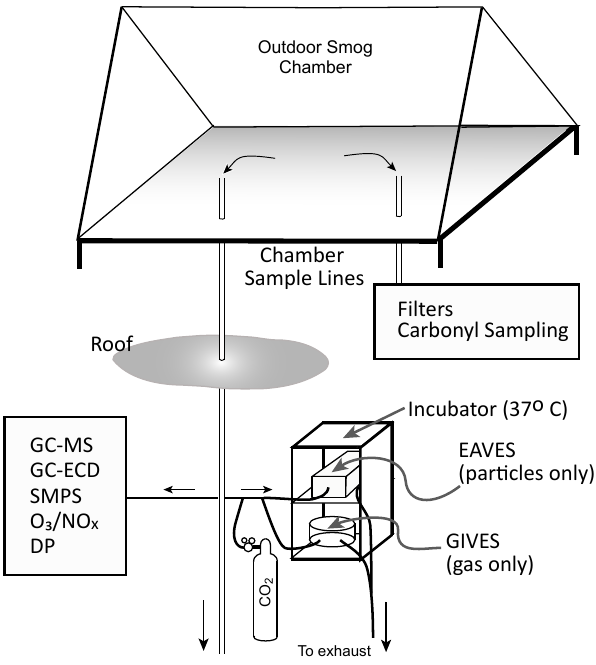
Fig. 1. Schematic of The Gillings Innovation Laboratory 120 m 3 Outdoor Chamber located on the roof of the four-story Gillings School of Global Public Health, UNC-CH. Sample lines pass through the floor of the chamber, the building’s roof, and then di- rectly into the chemistry and biological exposure laboratory on the fourth floor. Filter and carbonyl-specific sampling are performed on the roof directly through the chamber floor to minimize loss in sam- ple